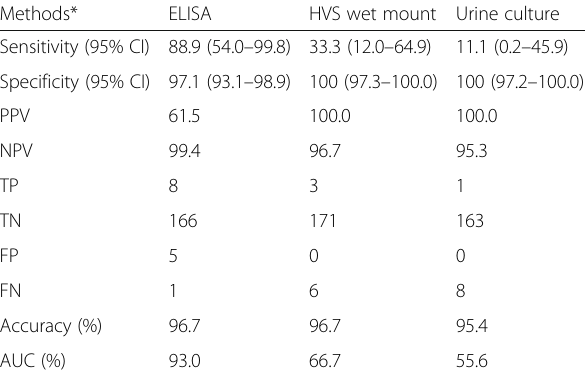
Table 4 Evaluation of the performance of test methods used Methods*